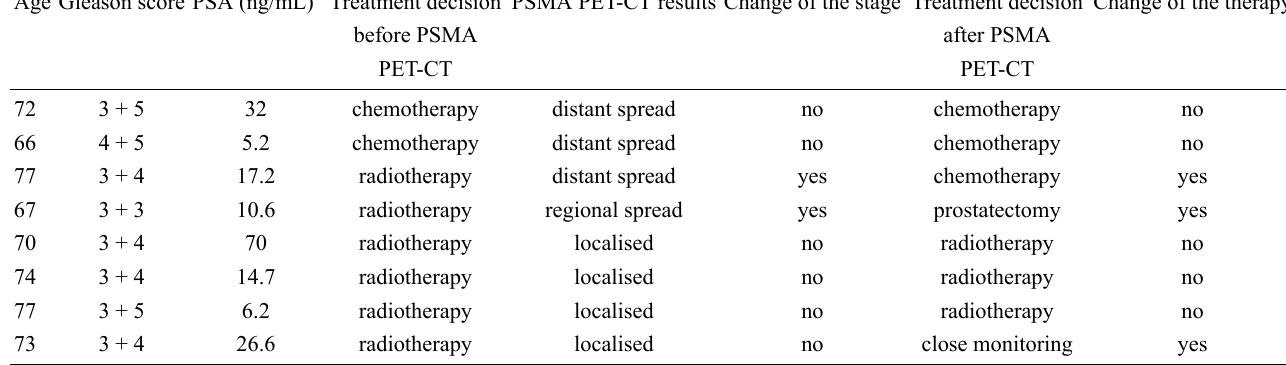
Table 2. Patients at primary